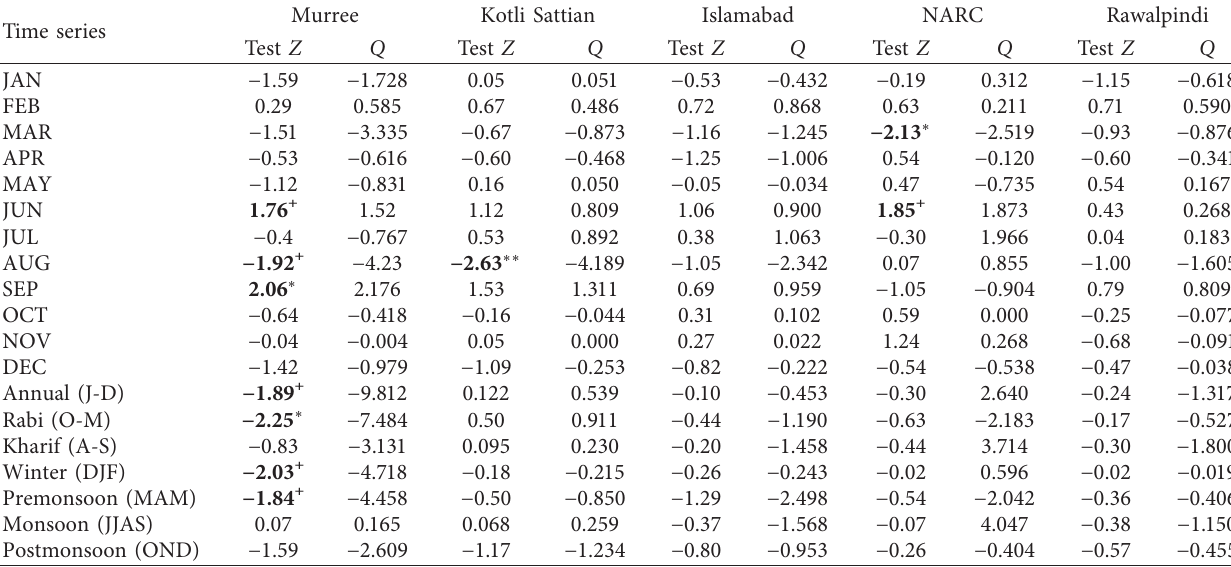
Table 3: Monthly, seasonal, and annual rainfall statistic in zone-1 stations using Mann–Kendall test and Sen’s slope estimate. Murree Time series